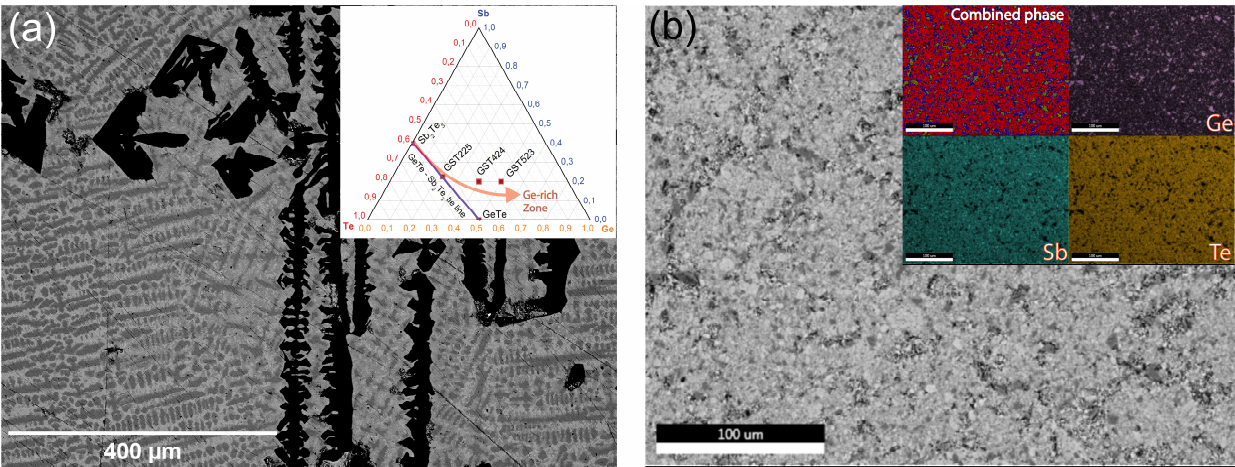
Figure 2. ( a ) GST523 crystalline target made by melting a combination of constituent elements at 950 °C. Clear phase separation is visible from the image. Inset shows a phase diagram of Ge-Sb-Te alloys indicating the tie-line of Sb 2 Te 3 -GeTe and the deviation toward Ge-rich GST regions. ( b ) Powder-sintered target, prepared by crushing the crystalline target for better yield and stoichio- metric transfer. Inset shows SEM EDX mapping of the powder-sintered target. A “single phase”-like powder target of GST523 was